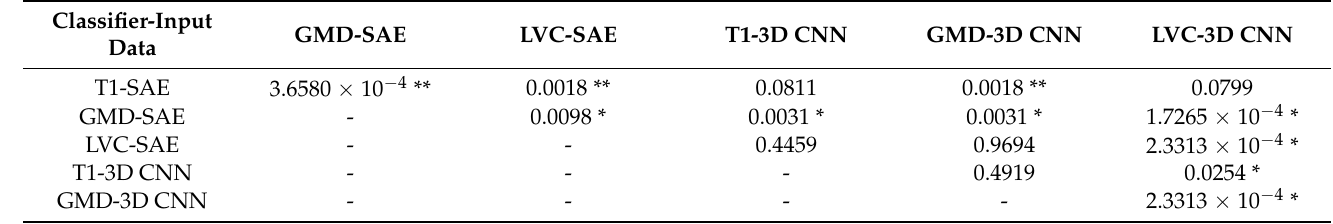
Table 6. p -values of the Mann-Whitney test comparing the accuracies obtained from 10 repetitions of the experiments for both classifiers (SAE, CNN) and all input feature types (T1, GMD, LVC). Significant results ( α = 0.05) in favor of the classifier, listed on the left, are marked with an asterisk (*). Those in favor of the classifiers listed above are marked with two asterisks